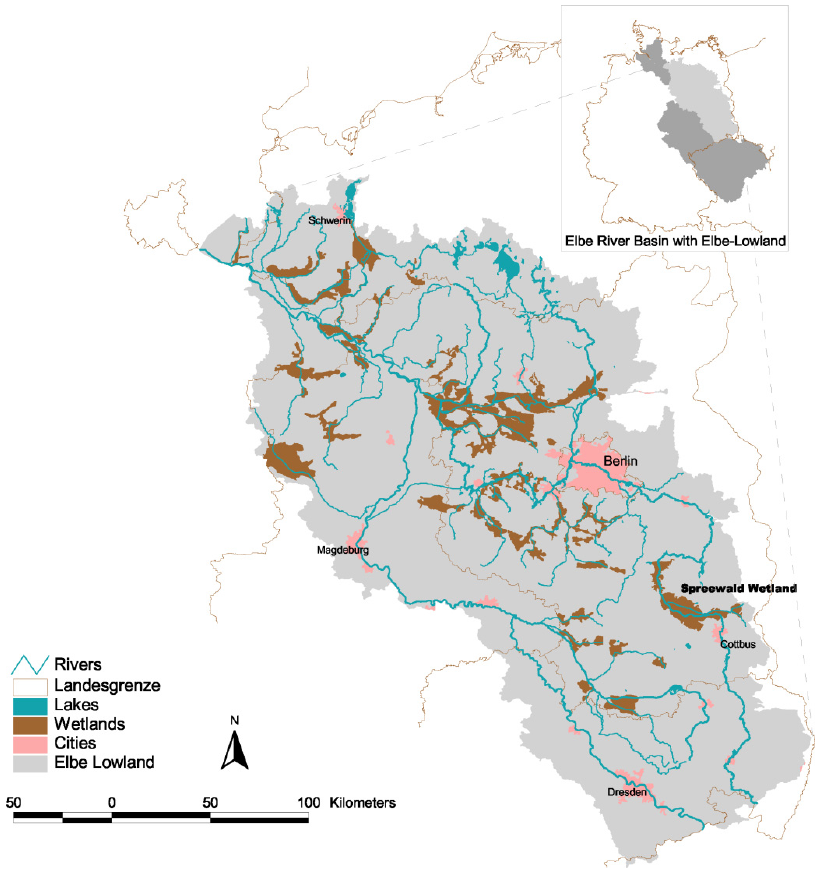
Figure 1. Location of the Spreewald Wetland study site and further wetlands within the Elbe Lowland.